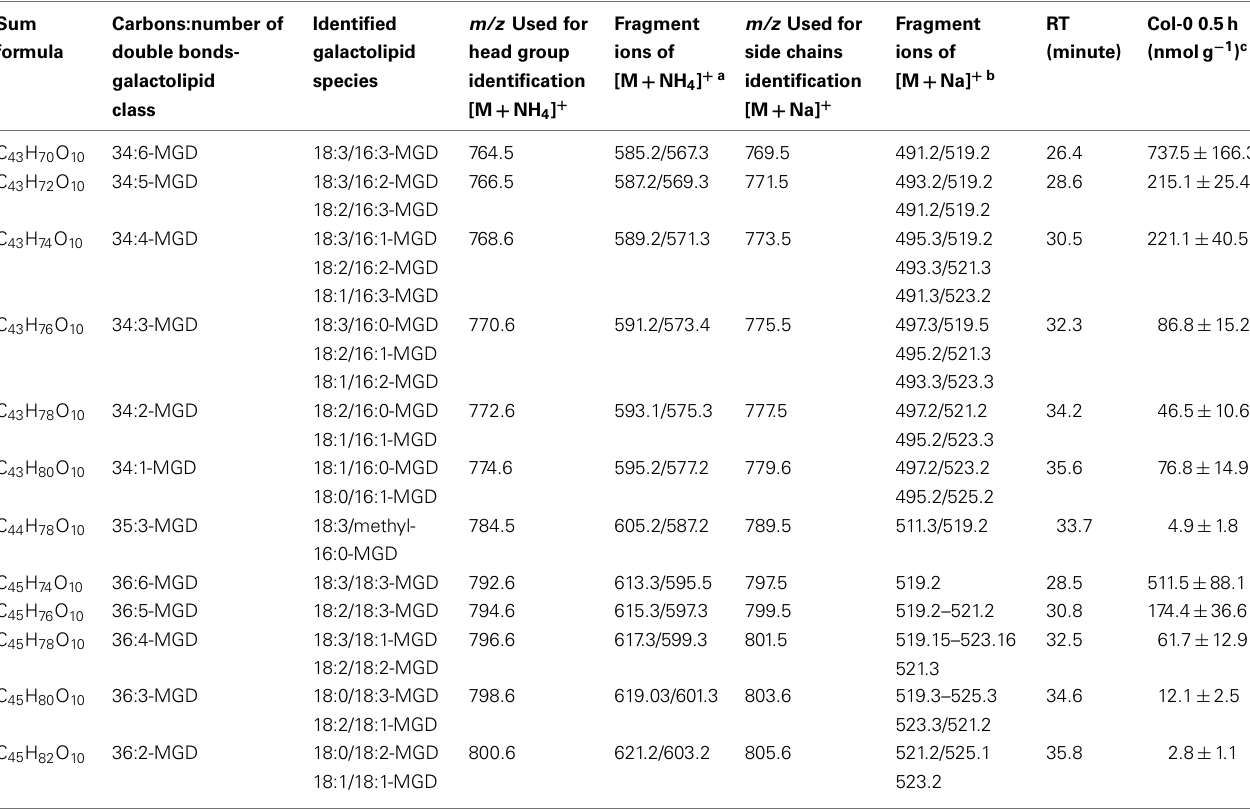
TableA1 | Non-oxidized MGD species identified in wounded A. thaliana leaves. Sum Carbons:number formula